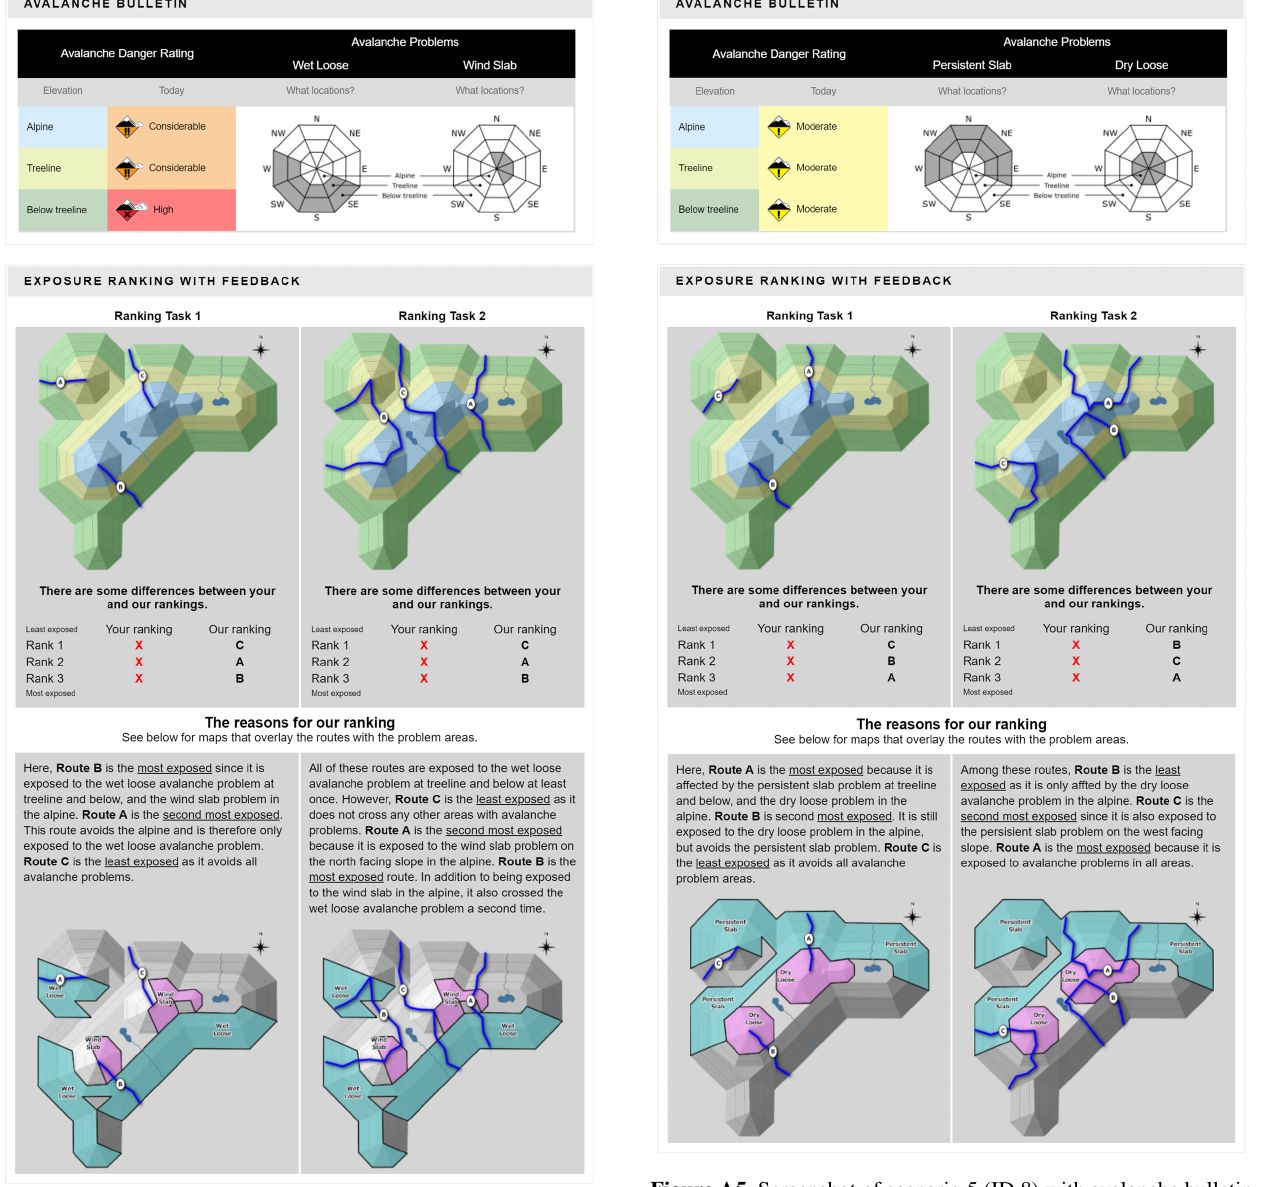
Figure A4. Screenshot of scenario 4 (ID 7) with avalanche bulletin information, route options, ranking solutions, and explanations.